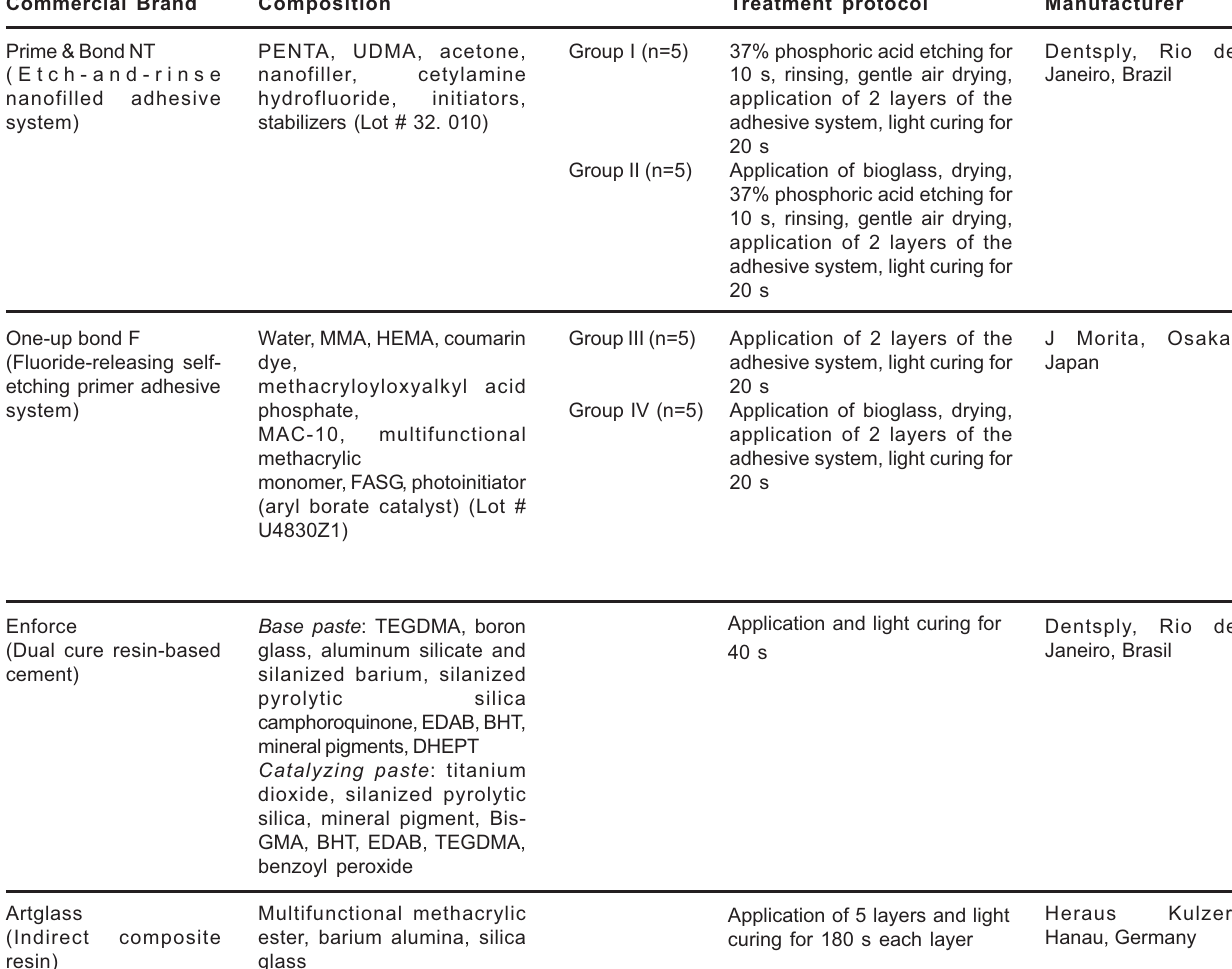
TABLE 1- Materials used and treatment protocol Commercial Brand